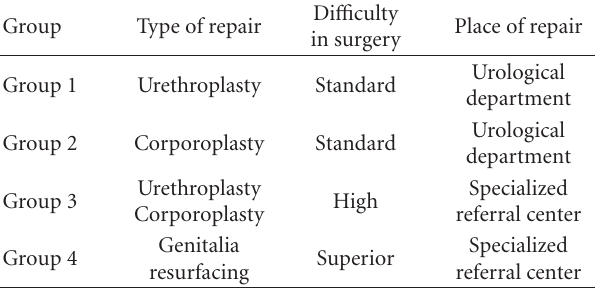
Table 2: Algorithm for surgical